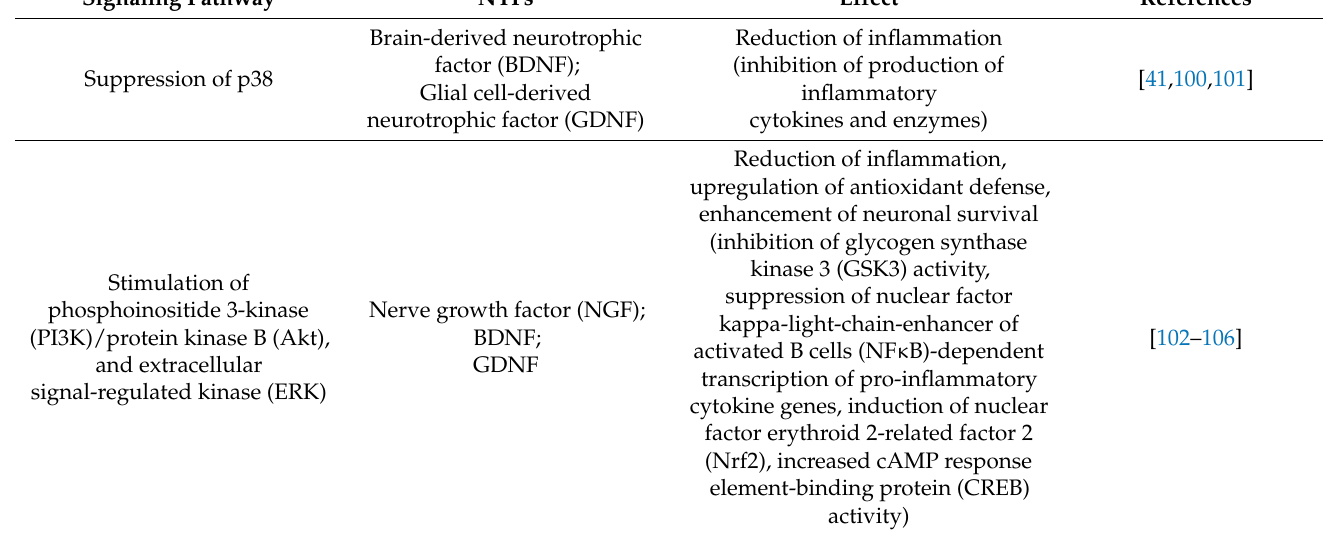
Table 2. Main signaling pathways involved in neurotrophic factors (NTFs) and glia-neuronal crosstalk. Signaling